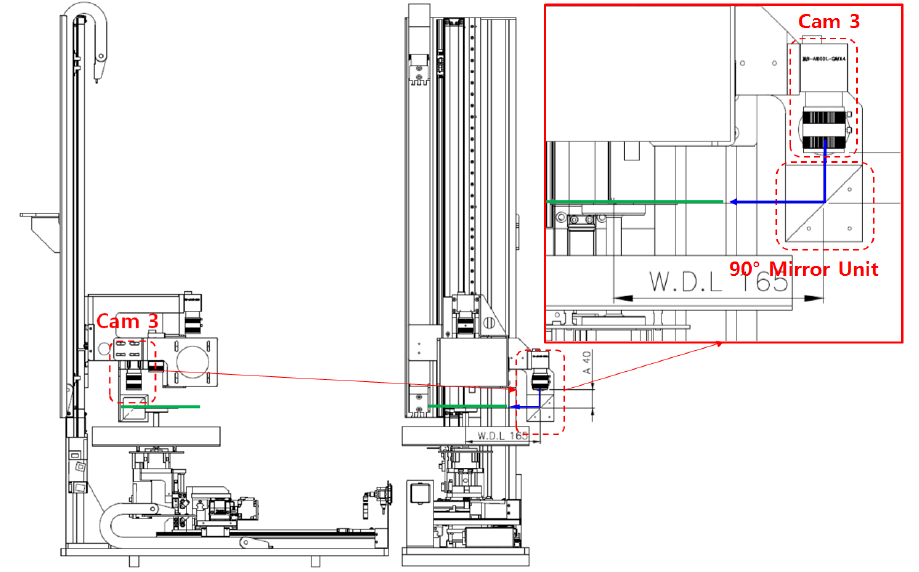
Figure 6. Vision aligner for UV tape detection.